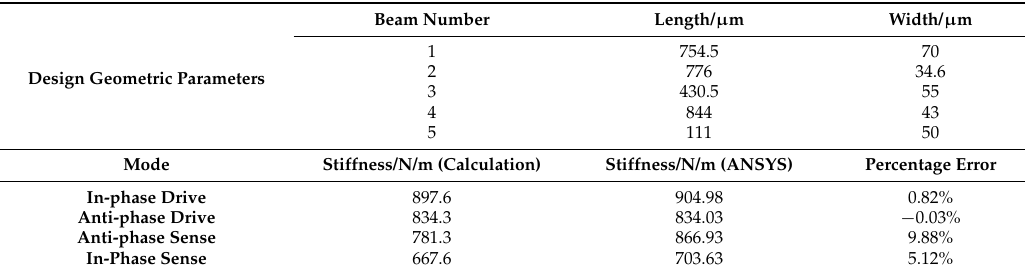
Figure 6. The finite element model of CSQMG with 35 μ m chamfer combining two different mesh size. The comb fingers are replaced by evenly distributed mass. Swept meshing with element size less than 0.02 mm is used on the beams. Table 2. Stiffness error comparison.